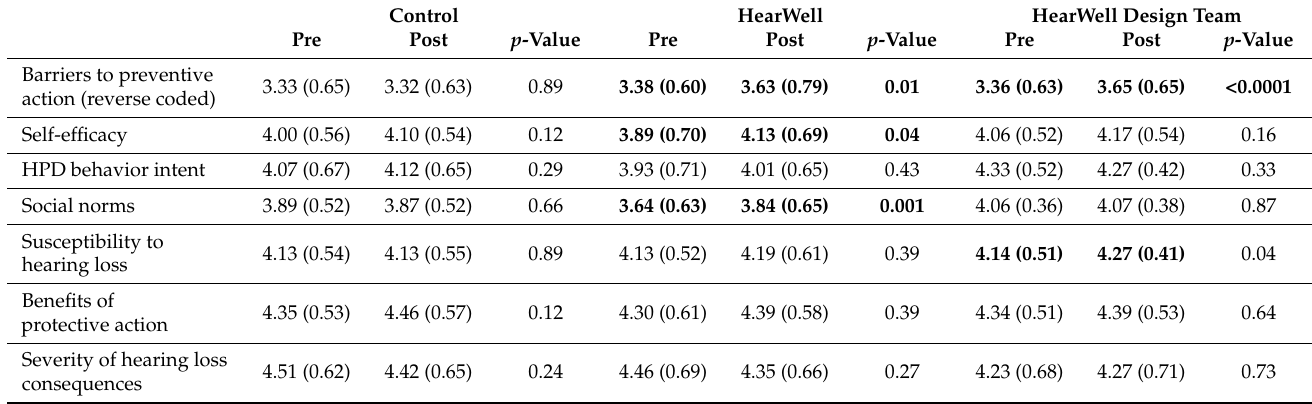
Table 4. Hearing protection belief, attitudes and behaviors (BAPHLS) sub-scales pre- and post-training by intervention arm. Mean (standard deviation) of values from 5-point Likert scale from totally disagree (1) to totally agree (5). Values are bolded to indicate statistically significant differences. p -values are from paired t -test between pre- and post-values. Control HearWell HearWell Design Team Pre Post p -Value Pre Post p -Value Pre Post p -Value Barriers to preventive action (reverse coded) HPD behavior intent 4.07